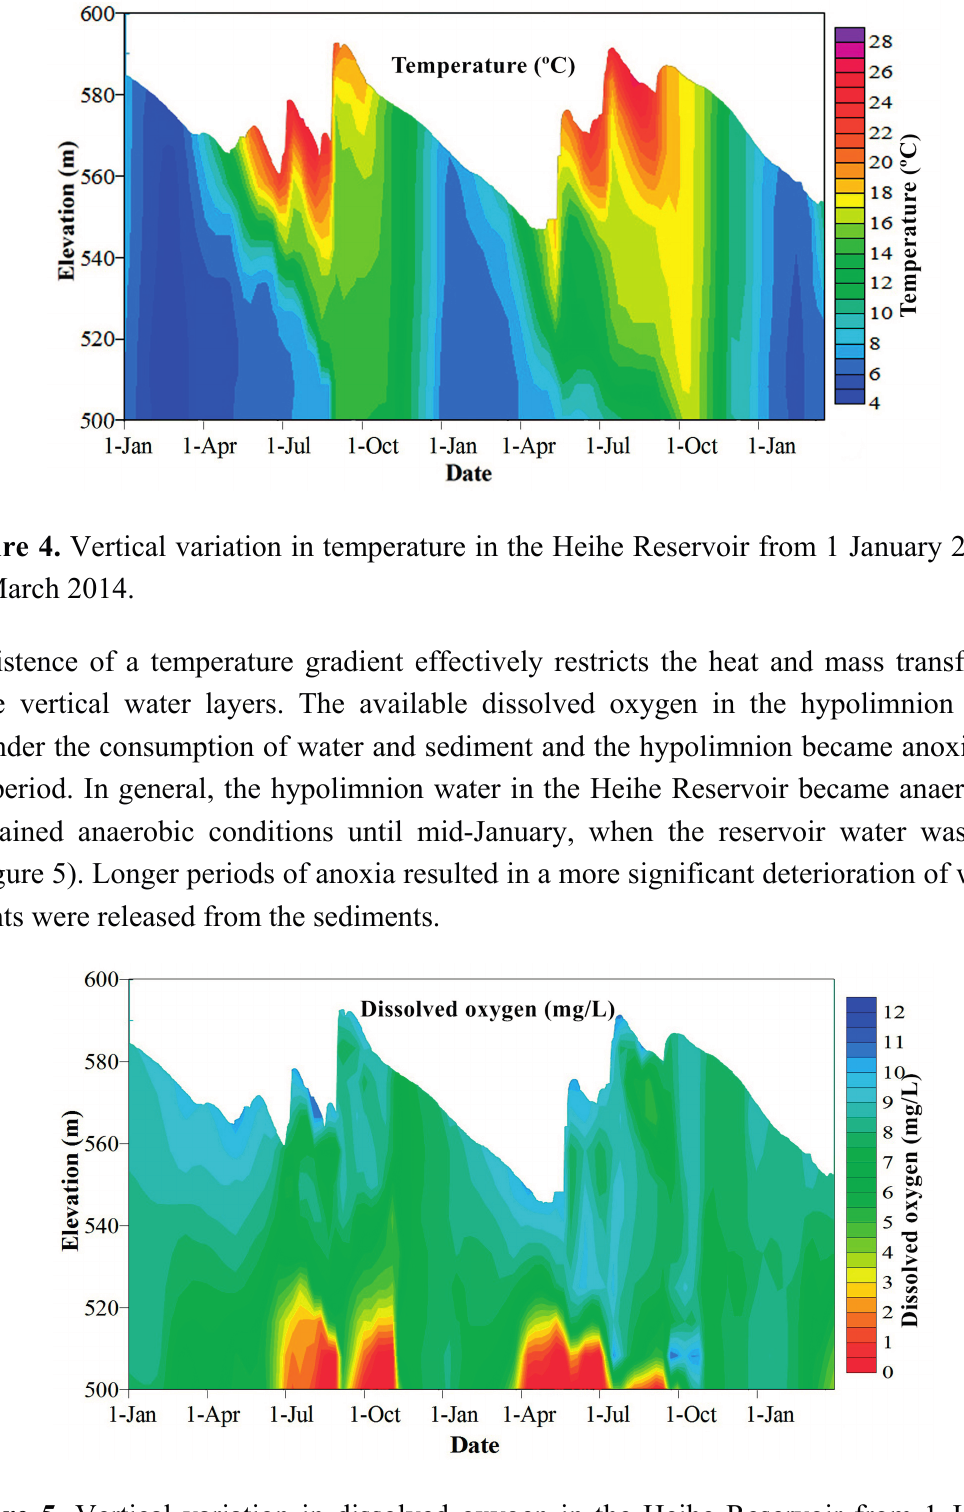
Figure 5. Vertical variation in dissolved oxygen in the Heihe Reservoir from 1 January 2012 to 31 March